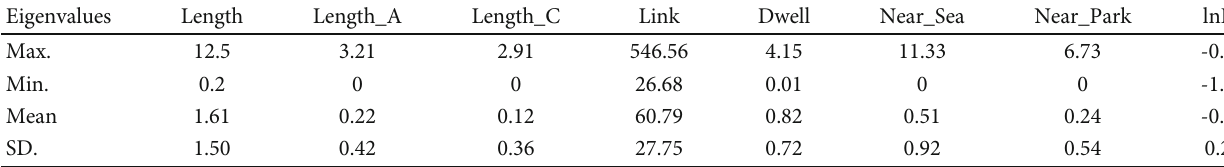
Table 4: Statistics on the attributes of the route chosen by